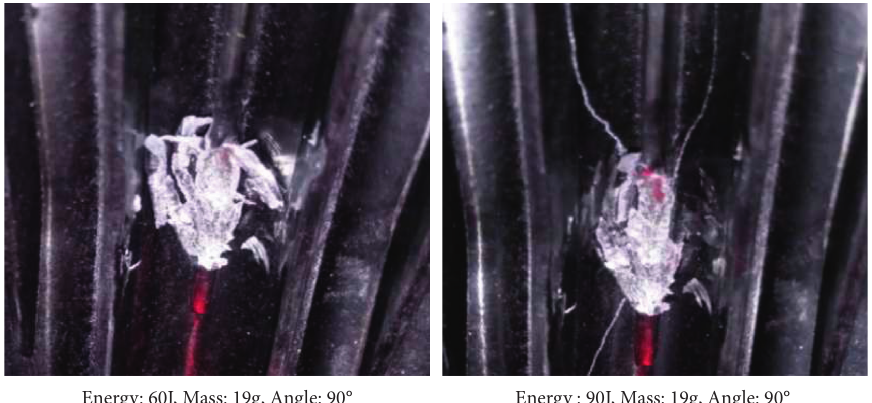
Figure 7: Damage photos of the oil sump after being impacted by a 19 g ball.